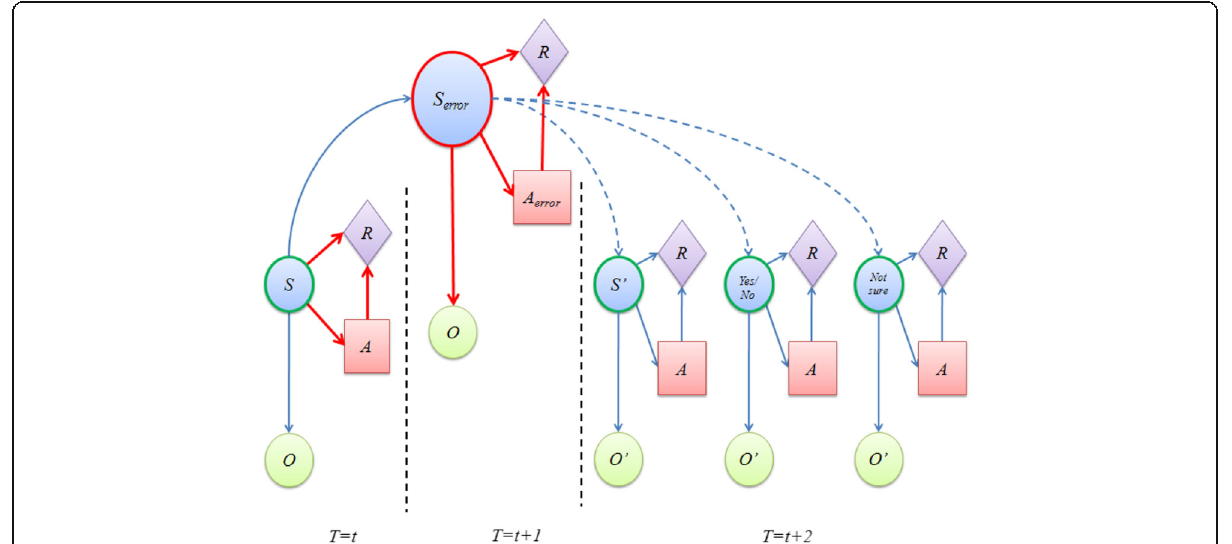
Fig. 10 Diagram of POMDP-based dialog state tracking with error